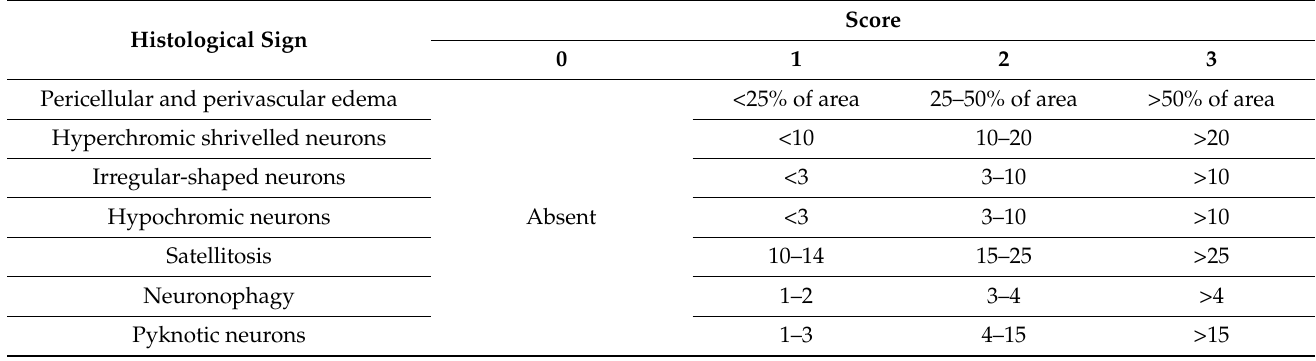
Table A2. Scoring of the severity of cerebral tissue